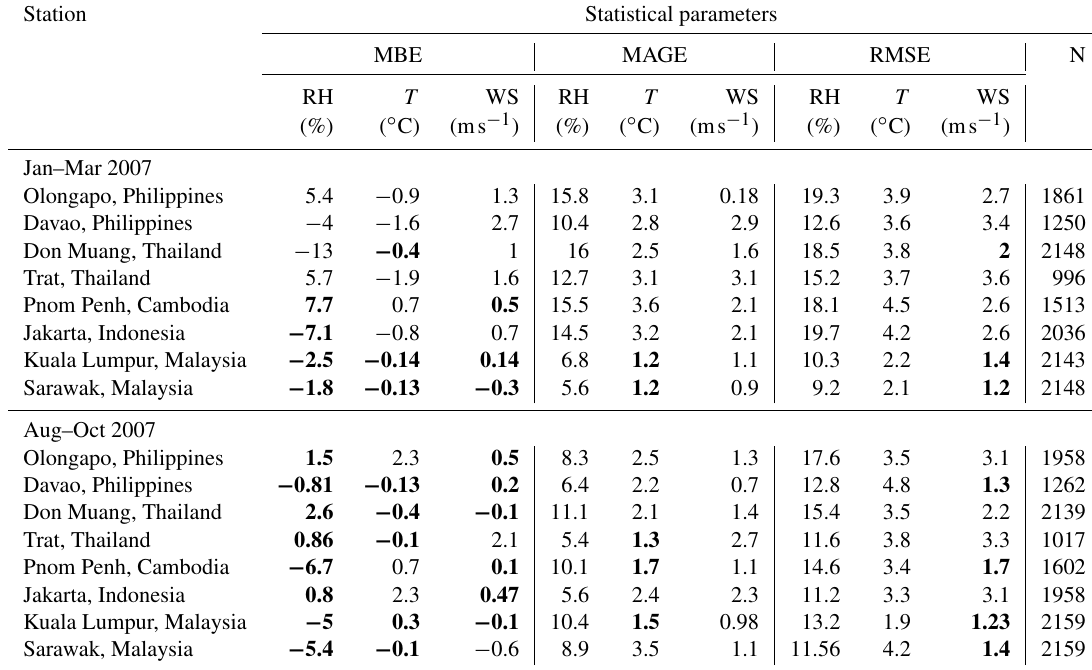
Table 3. Statistical parameters for WRF model performance evaluation for two periods (bold values are those meeting the evaluation criteria). Station Statistical parameters MBE MAGE RMSE